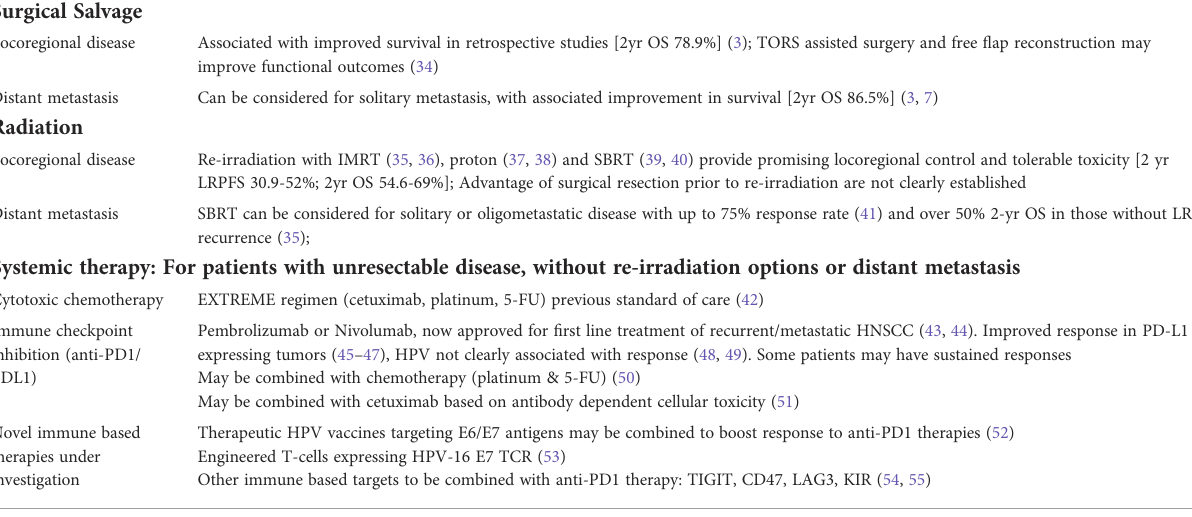
TABLE 2 Salvage treatment options. Surgical Salvage Locoregional